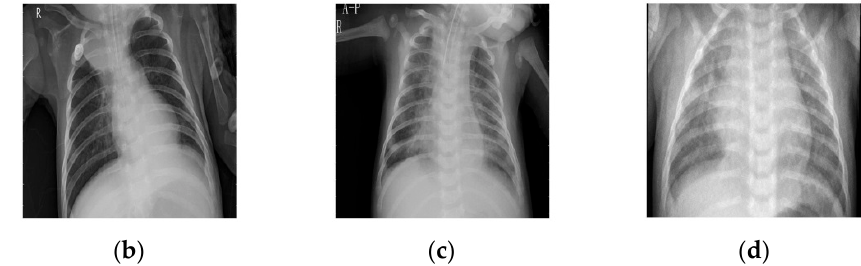
Figure 2. COVID-19 reference CT image dataset; ( a ) CT1 image; ( b ) CT2 image; ( c ) CT3 image; ( d ) CT4 image.